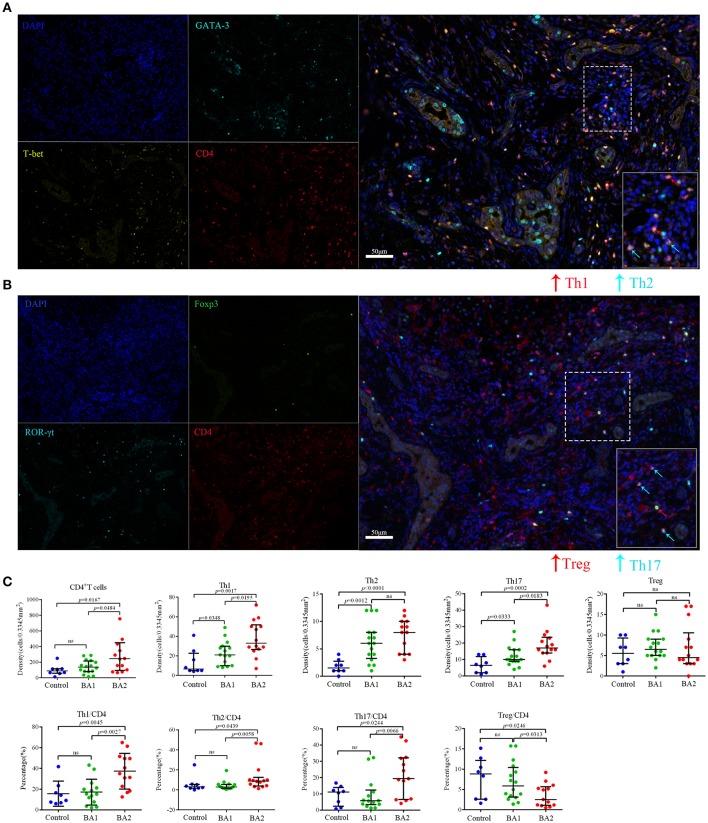
Representative mIHC images and statistical analyses of CD4+T cell subsets. (A) The four images on the left side were single stain of DAPI (blue), CD4 (red), T-bet (yellow), and GATA-3 (cyan). Merged image on the right side showed Th1 (CD4+T-bet+) and Th2 (CD4+GATA3+) cells. The lower right image in the merged image was the magnification of dotted line area. (B) The four images on the left side were single stain of DAPI (blue), CD4 (red), ROR-γt (cyan), and Foxp3 (green). Merged image on the right side showed Th17 (CD4+ROR-γt+) and Treg (CD4+Foxp3+) cells. The lower right image in the merged image was the magnification of dotted line area. (C) Analyses of the densities and percentages of CD4+T cell subsets among control (choledochal cyst), BA1 (good prognosis) and BA2 (poor prognosis) groups. Mann-Whitney test was used.